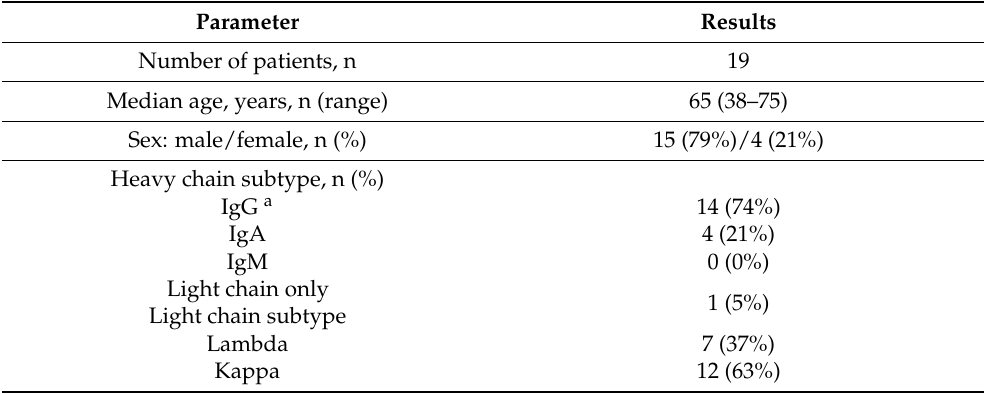
Table 1. Patient characteristics at